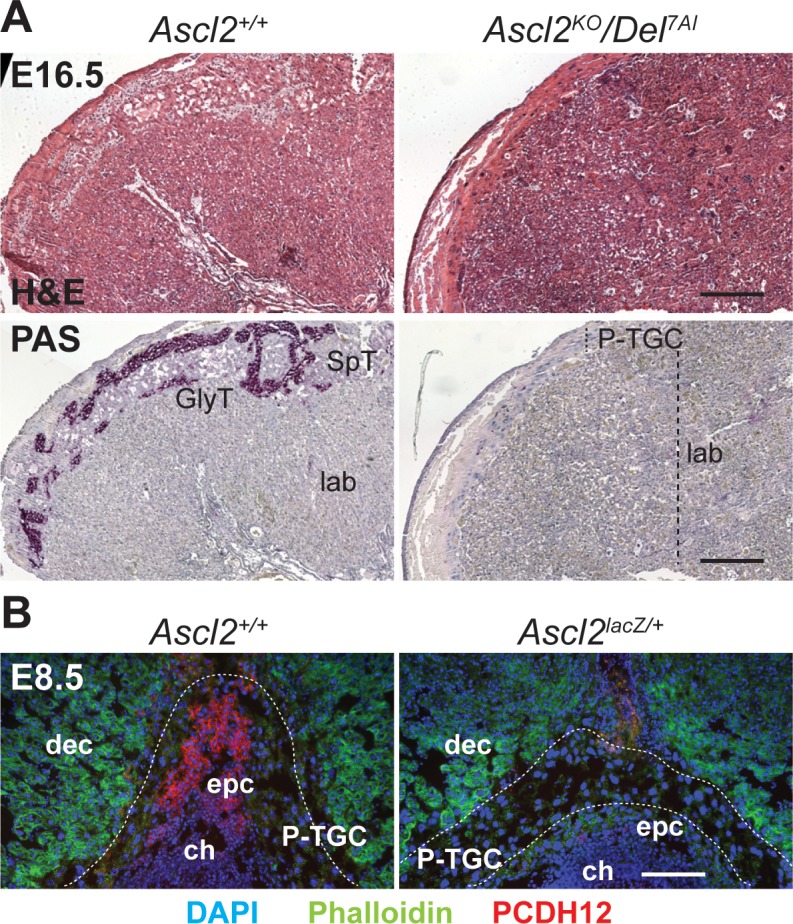
Absence of glycogen cell precursors in Ascl2 mutant placentae.(A) Histological sections of wild-type and rescued Ascl2KO/Del7AI placentae at E16.5 were stained with heamatoxylin and eosin (H&E, top) or PAS with heamatoxylin nuclear counter-stain (bottom). SpT, spongiotrophoblast cells; lab, labyrinthine layer; GlyT, glycogen trophoblast cells; P-TGC, parietal trophoblast giant cells. Scale bar: 0.5 mm. (B) Immunofluorescence staining with PCDH12 polyclonal antibodies (red) and phalloidin (green) on cryosections of E8.5 wild-type and Ascl2lacZ/+ conceptuses, counterstained with DAPI (blue). Scale bar: 0.1 mm.